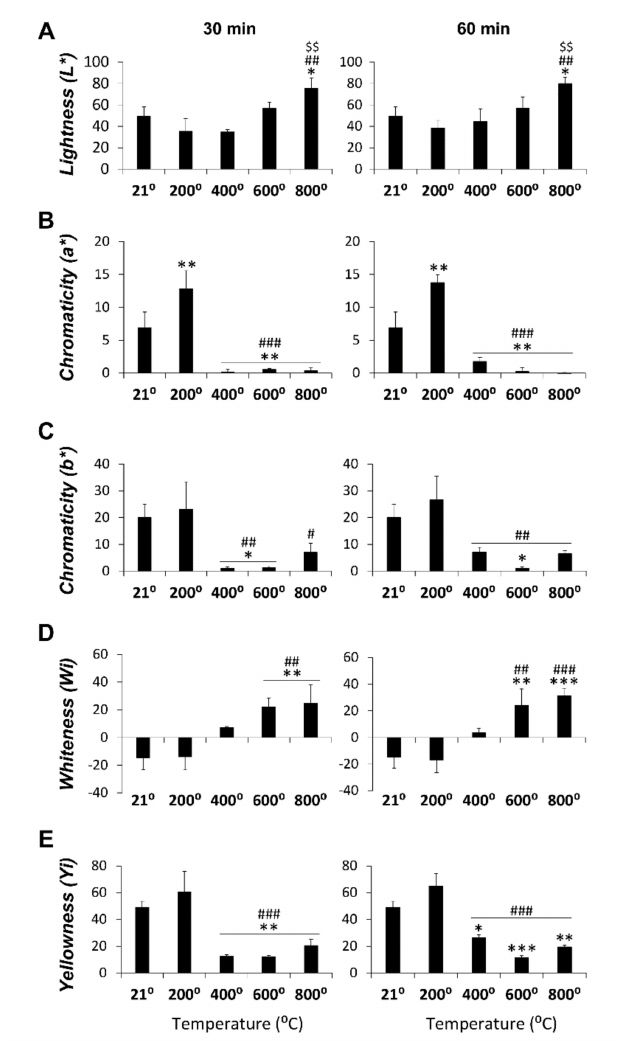
Figure 3. Spectrophotometric color measurements in cortical bone zone (L*, a*, b*, whiteness index (WI), and yellowness index (YI)) in the control and those heated at 200, 400, 600, and 800 °C for 30 and 60 min. ( A ): Lightness parameter for 30 and 60 min; ( B ): Chromaticity a* parameter for 30 and 60 min; ( C ): Chromaticity b* parameter for 30 and 60 min; ( D ): Whiteness parameter for 30 and 60 min and ( E ): Yellowness parameter for 30 and 60 min. Histograms represent means ± SEM ( n = 4). ANOVA: * / ** / *** p < 0.05 / 0.01 / 0.001 vs. control group, # / ## / ### p < 0.05 / 0.01 / 0.001 vs. 200 °C, $$ p < 0.01 vs. 400